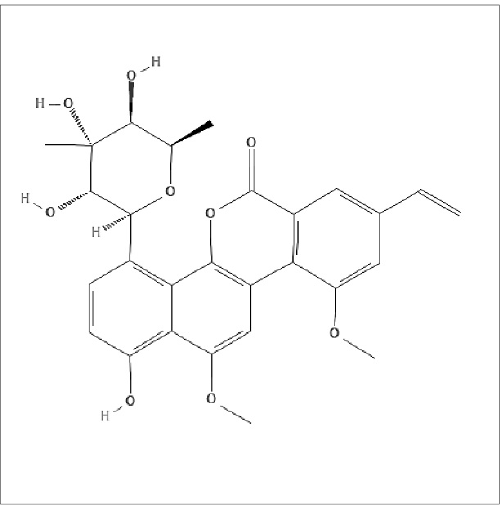
Figure 1. Structure of chrysomycin A.